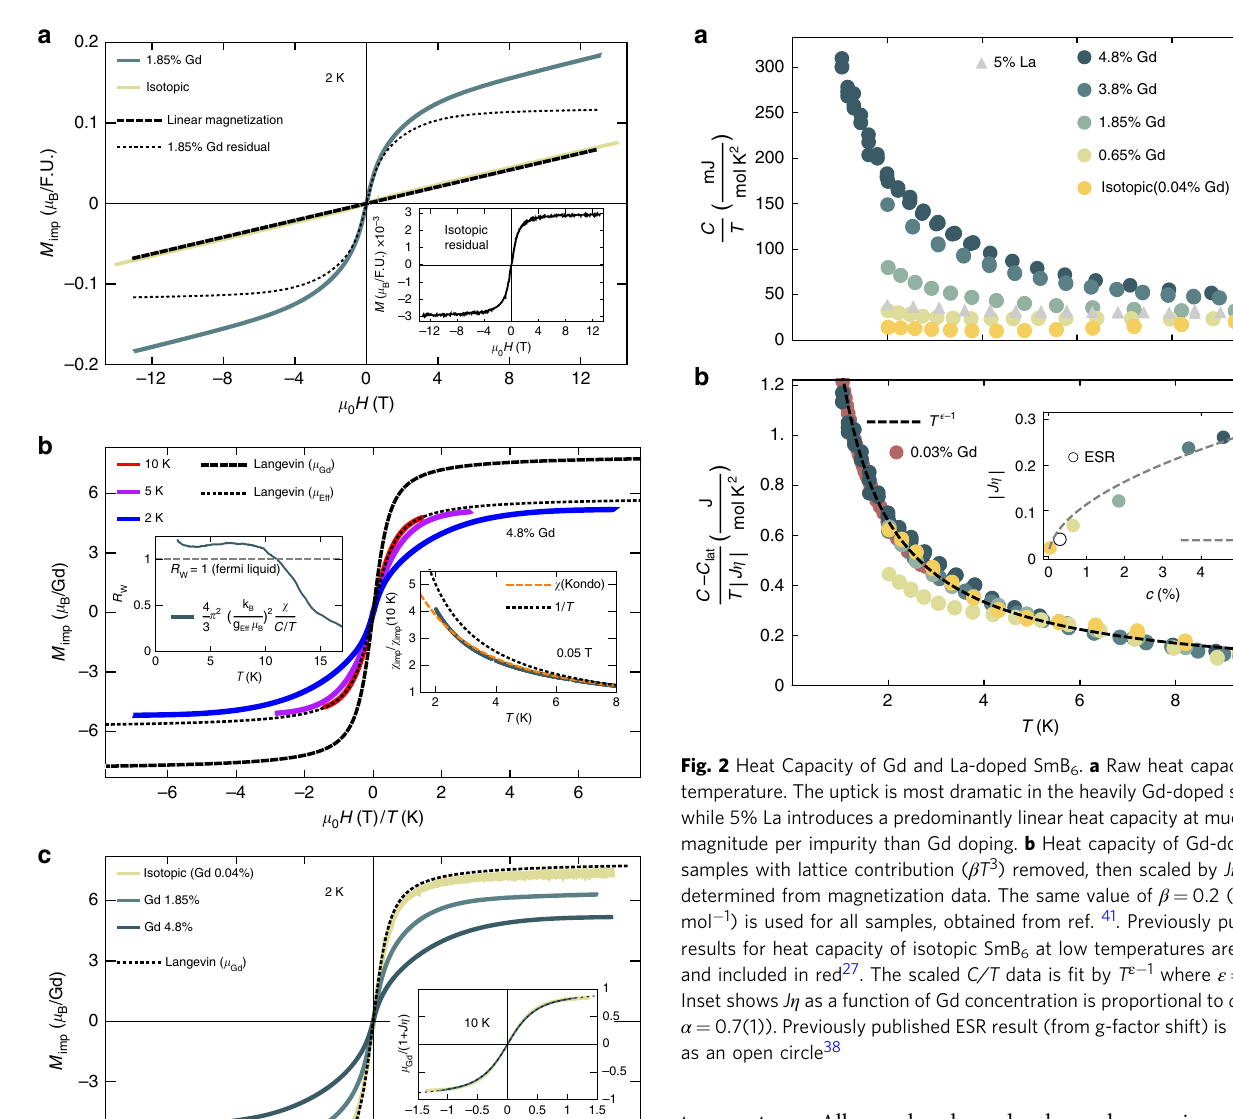
temperatures. All samples showed enhanced screening at lower temperatures. Speci fi c heat . After subtracting the lattice contribution ( β T 3 ; β ¼ 0 : 2 (mJ K − 4 mol − 1 )), we scaled the speci fi c heat by 1 = j J η j , Fig. 2b. For a constant J , this amounts to scaling by the Fig. 1 Magnetization of SmB 6 . a Raw magnetization of 1.85% Gd-doped moment screening DOS. The data converges to a single curve (the sample and isotopic 154 Sm 11 B 6 (colors). After removing a linear lightly doped but not isotopically puri fi ed 0.6% sample may not magnetization (dashed line) from both, the residual magnetization looks be dominated by Gd impurities). This scaling indicates the decidedly paramagnetic (dotted line in main fi gure shows 1.85%, inset leading interactions are independent of doping, which is incon- shows isotopic on a smaller scale). We ascribe the linear contribution as sistent with an origin in interactions between impurities. In our intrinsic to SmB 6 and the residual magnetization to impurities. Details of the 5% targeted La-doped sample, we observed a linear heat capacity fi tting are included in Supplementary Note 1. b Residual magnetization of ≈ 40 mJ/mol-K 2 , similar to previous studies of electron-doping 4.8% Gd-doped sample at 2 K, 5 K, and 10 K, vs μ 0 H / T . Insets show the via carbon impurities. This is dramatically less than the low Wilson Ratio, R w , of this sample becoming approximately constant at low temperature heat capacity observed for our 5% Gd-doped sample, temperatures and the similarity of χ ( T ) to the Kondo impurity model rather which rises above 300 mJ/mol-K 241 . This indicates the involve- than a Curie-like susceptibility (constant Van Vleck contribution has been ffiffiffiffiffiffiffiffiffiffiffiffiffiffiffi p ment of impurity magnetism in the low energy DOS of Gd-doped ¼ μ removed). g Eff in the R w was determined by g Eff . c Residual J ð J þ 1 Þ Eff samples. magnetization at 2 K of samples with varying doping levels. Inset shows The scaled speci fi c heat has power-law dependence, T ε that at 10 K a data collapse is achieved when scaling M Imp and H/T with (1 ð C = T / T ε (cid:2) 1 Þ , where ε = .02(1), Fig. 2b. Previously published + J η ) and 1/(1 + J η ), respectively speci fi c heat data can be scaled to follow the same power law fi t to 0.4 K, below which the power law fi t diverges above the measured is qualitatively consistent with the Kondo impurity model